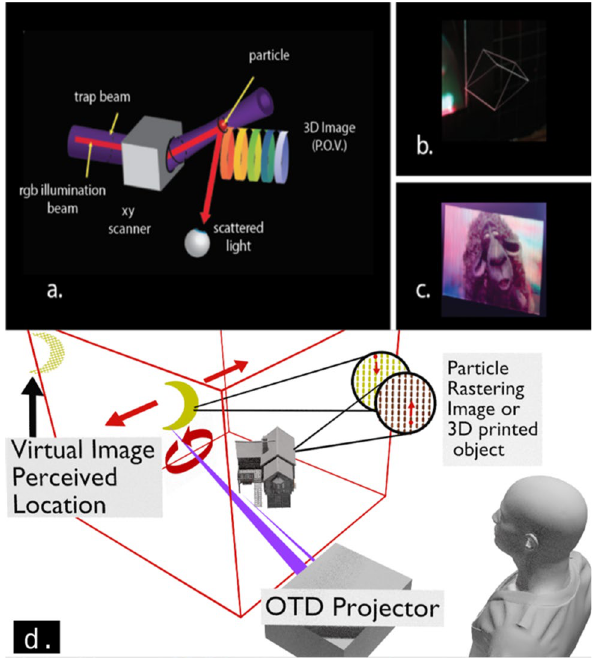
Figure 1. OTD display and simulated virtual images concept. ( a ) Optical trap display (OTD). ( b ) 3D vector, long exposure, image drawn by OTD. ( c ) Flat, rastered, long-exposure image drawn by OTD; content from Cosmos Laundromat, (CC) Blender Foundation|gooseberry.blender.org. ( d ) Simulated virtual image concept with flat moving/rotating plane at the back of a draw volume filled with real images/objects such as 3D OTD images or 3D printed